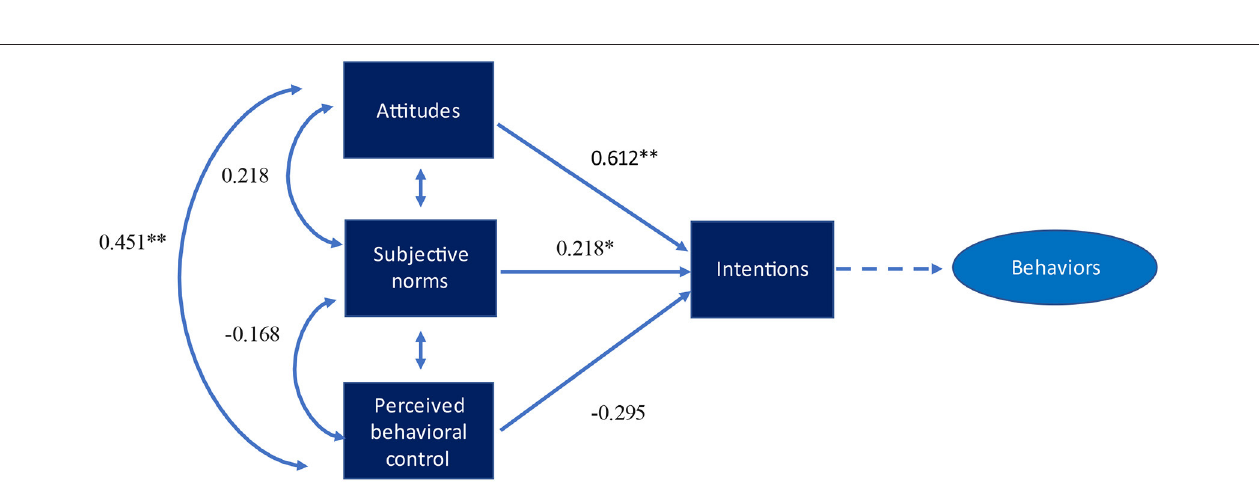
FIGURE 3 | Path model with standardized regression coefficients for being reflective in digital world. * p < 0.05; ** p < 0.01.